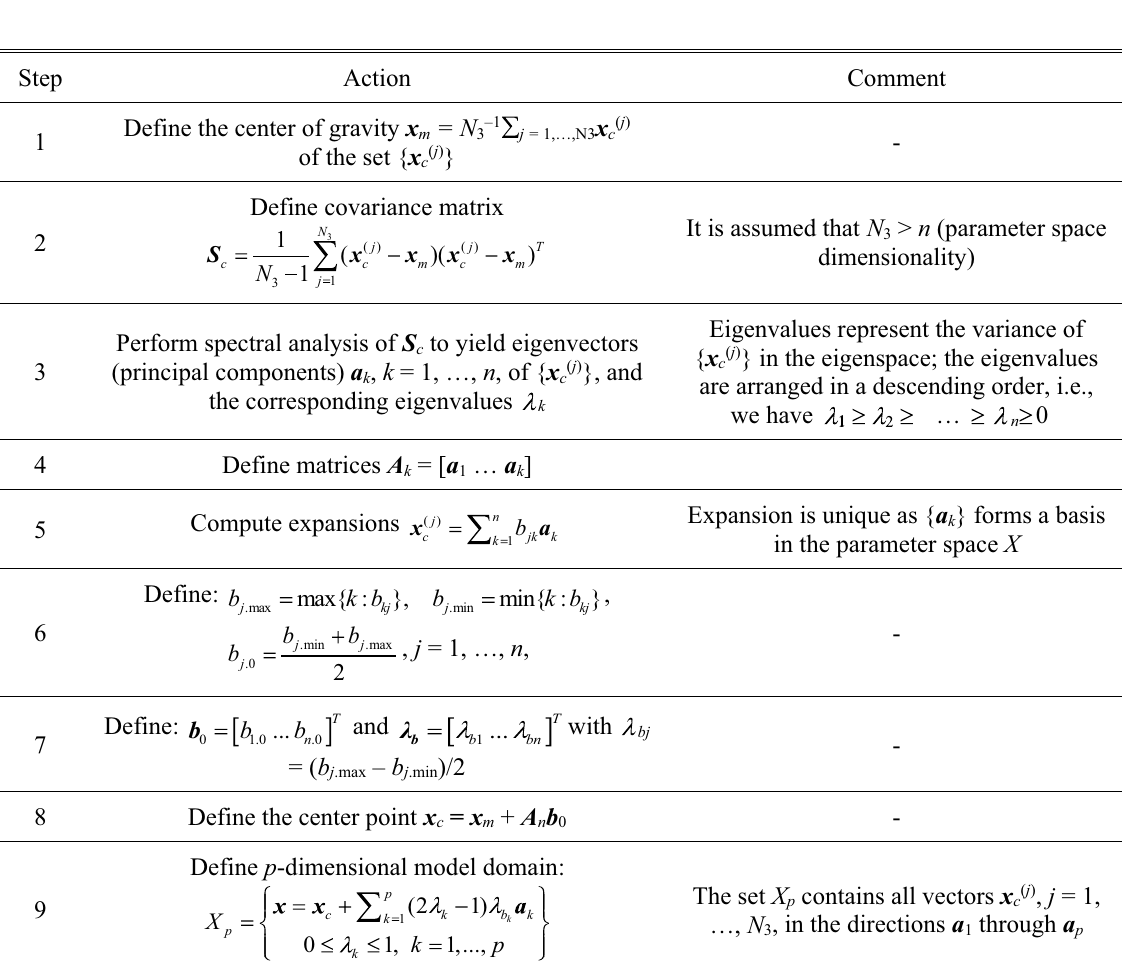
Figure 3. Definition of reduced-dimensionality surrogate model domain.